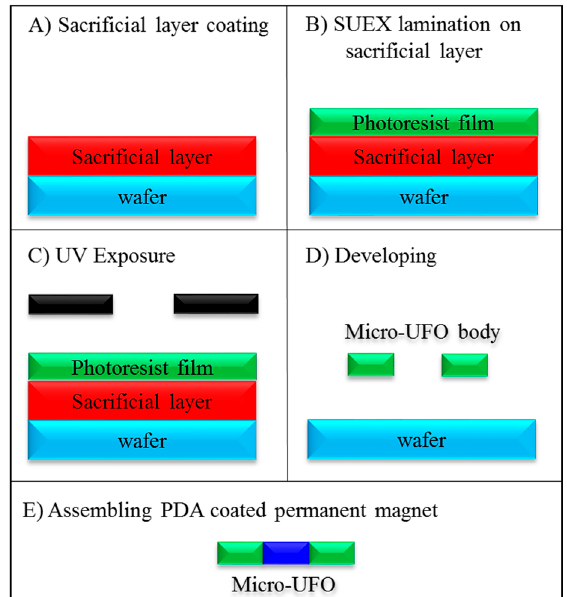
Figure 9. Fabrication process of the micro-UFO. ( A ) Sacrificial layer coating; ( B ) SUEX lamination on sacrificial layer; ( C ) UV Exposure; ( D ) Developing; ( E ) Assembling polydopamine (PDA) coated permanent magnet.